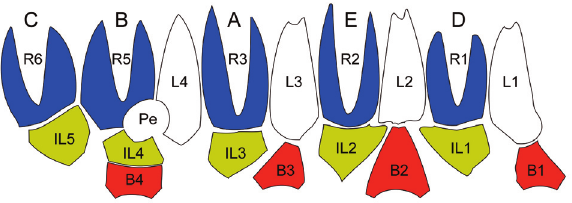
Fig. 3. Arrangement of thecal plates in Cystoblastus kokeni Jaekel, TUG 1086­3, Kukruse Regional Stage (Viivikonna Formation), Tallinn, Estonia. A–E, ambulacra according to Carpenter (1884, 1891); B1–B4, basal plates; IL1–IL5, infralaterals; L1–L4, laterals; Pe, periproct surrounding the anus; R1–R3, R5, R6, radial plates. See text for further